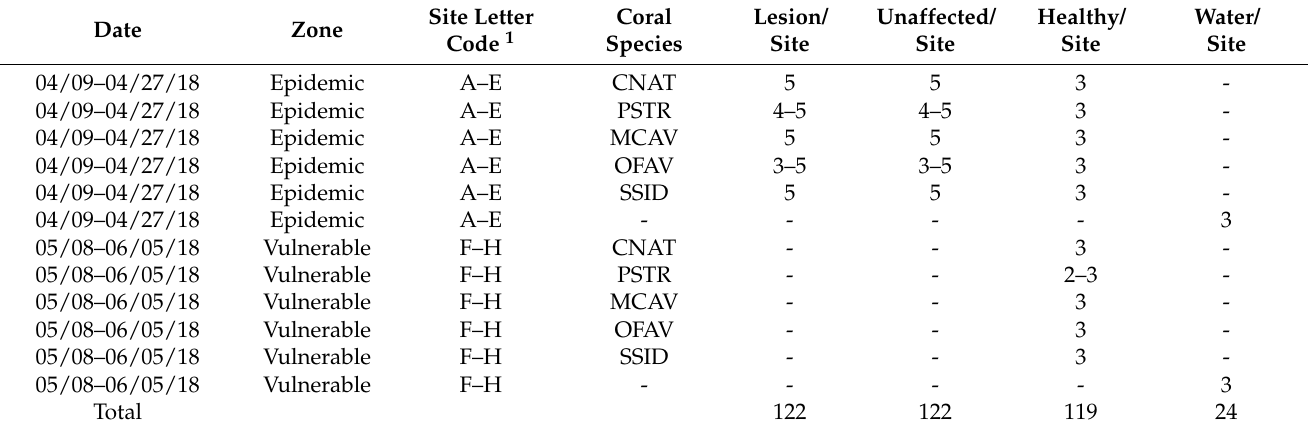
Table 1. Summary of coral tissue/mucus and water samples collected from sites (n = 8; Figure 1) along Florida’s Coral Reef. Shown are the dates of sampling, stony coral tissue loss disease (SCTLD) zone, site letter codes, and coral species sampled: Colpophyllia natans (CNAT), Pseudodiploria strigosa (PSTR), Montastraea cavernosa (MCAV), Orbicella faveolata (OFAV), and Siderastrea siderea (SSID). For each coral species, the number of lesion and unaffected tissue samples from colonies with SCTLD, and the number of samples from apparently healthy colonies, collected per site are shown. The number of water samples collected per site is also shown.